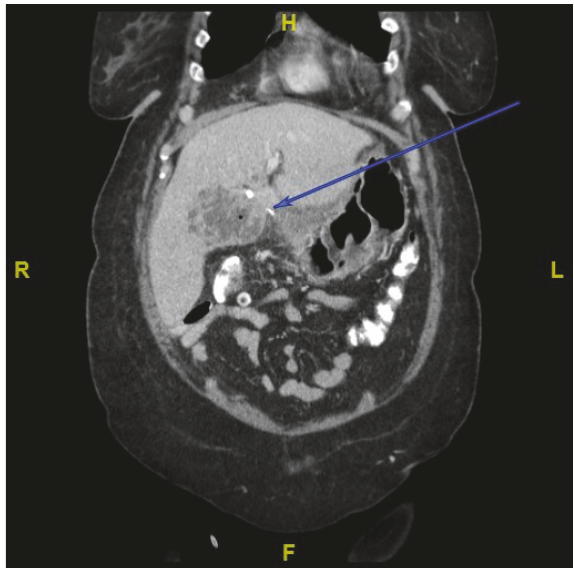
Figure 1: CT on admission illustrating hepatic abscess of left lobe with adjacent foreign body.